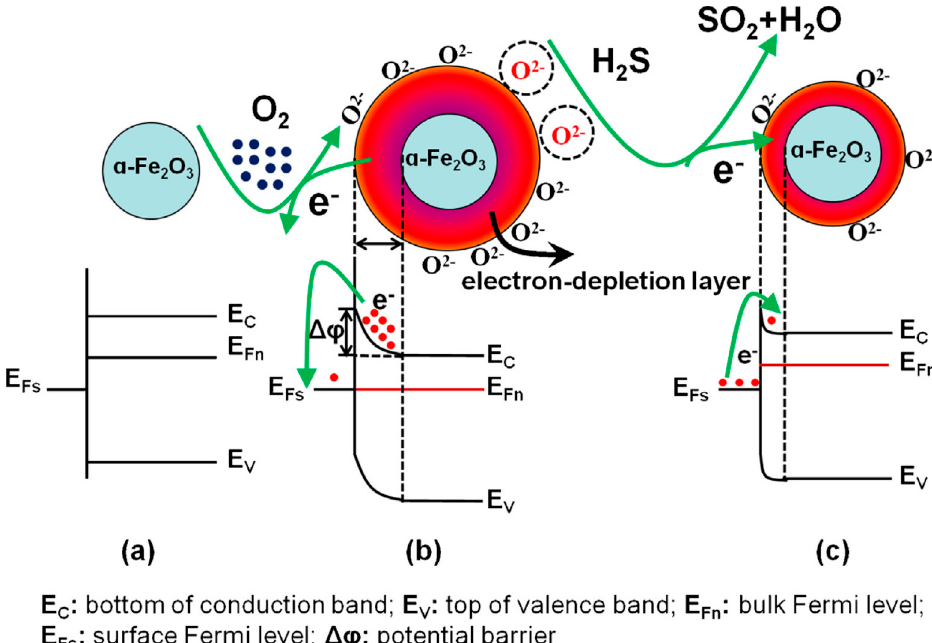
Figure 1. Band diagrams and schematic images of the surface reactions of an α -Fe 2 O 3 nanograin under different atmospheres, while kept at the optimal operating temperature (i.e., 300 °C): ( a ) under inert atmosphere (e.g., Ar); ( b ) exposed to air ( c ) in the presence of H 2 S diluted in air. Reproduced from [15], with permission from Elsevier.